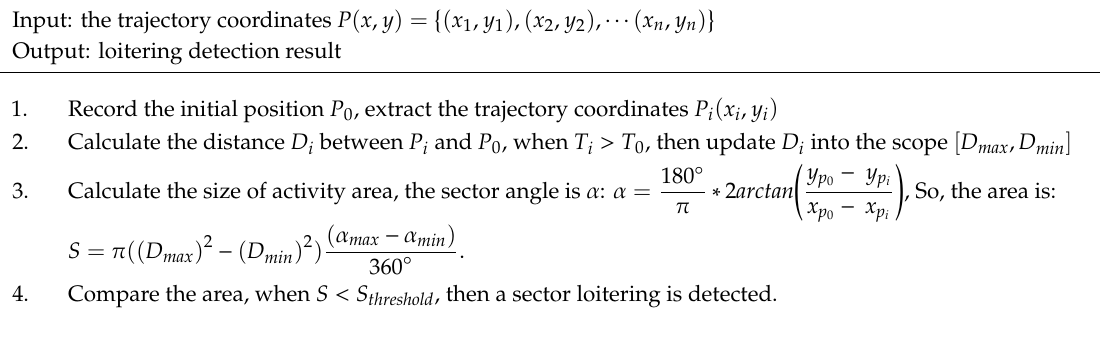
Figure 9. Demonstrate a sector trajectory and its corresponding calculation. Algorithm 3: Sector loitering detection